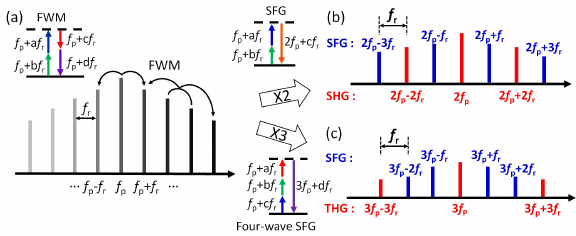
Figure 7: Schematics of multi-comb generation with the same rep- etition rate ( f r ) from the combination of various nonlinear effects: FWM, SFG and FSFG. (a) The initial IR comb generation from cas- caded FWM. (b) The second comb near the doubled frequency, 2f p , arising from SHG and SFG of the initial comb. (c) The third comb near the tripled frequency, 3f p , generated from THG and FSFG of the initial comb. FWM: four-wave mixing; SFG: sum frequency gen- eration; FSFG: four-wave sum frequency generation; SHG: second harmonic generation; THG: third harmonic generation.